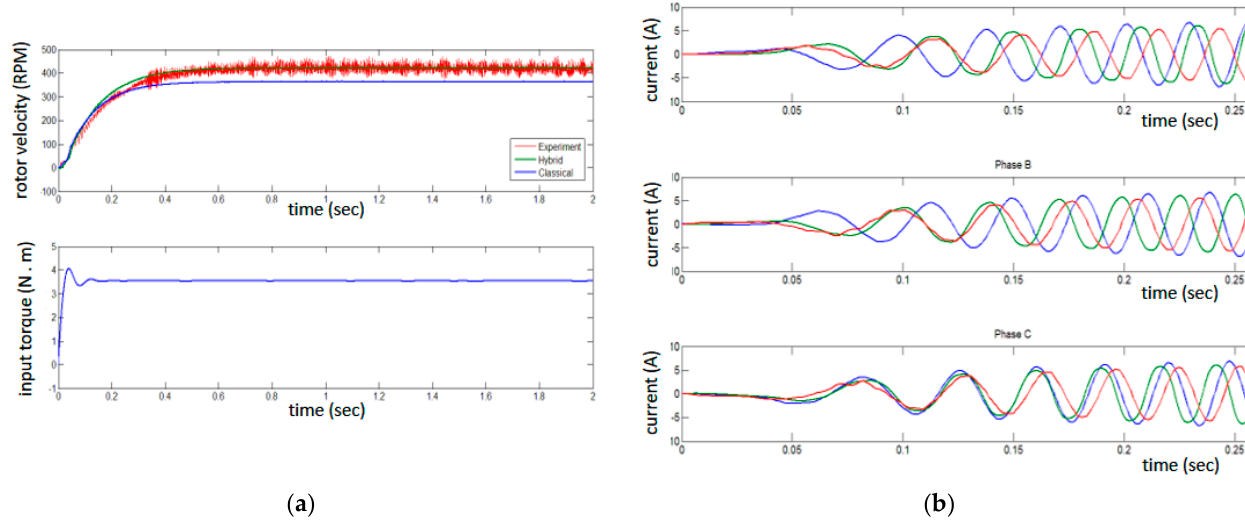
Figure 9. Low-speed transient response, showing ( a ) the rotor velocity and input torque and ( b ) a comparison of the stator currents. The plots show a comparison of the classical model (blue trace), hybrid model (green) and experimental measurements (red).